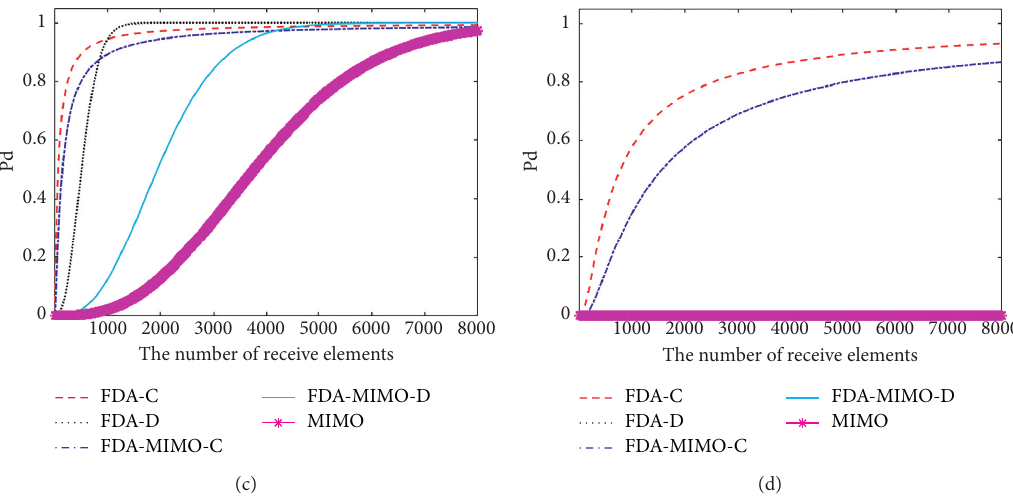
Figure 6: Detection probability of various radar systems with the SNR of 10dB, 0dB, − 10dB, and − 20dB. (a) ρ � 10dB. (b) ρ � 0dB. (c) ρ � − 10dB. (d) ρ � −